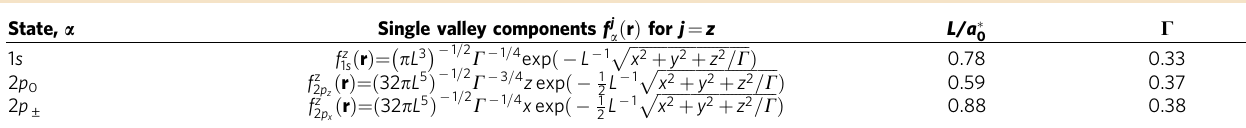
Table 1 | KL wavefunctions and parameter. State,